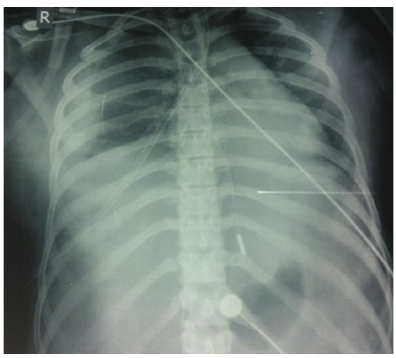
Figure 1: Moderate pleural effusion with a large cardiac silhouette suggestive of pericardial